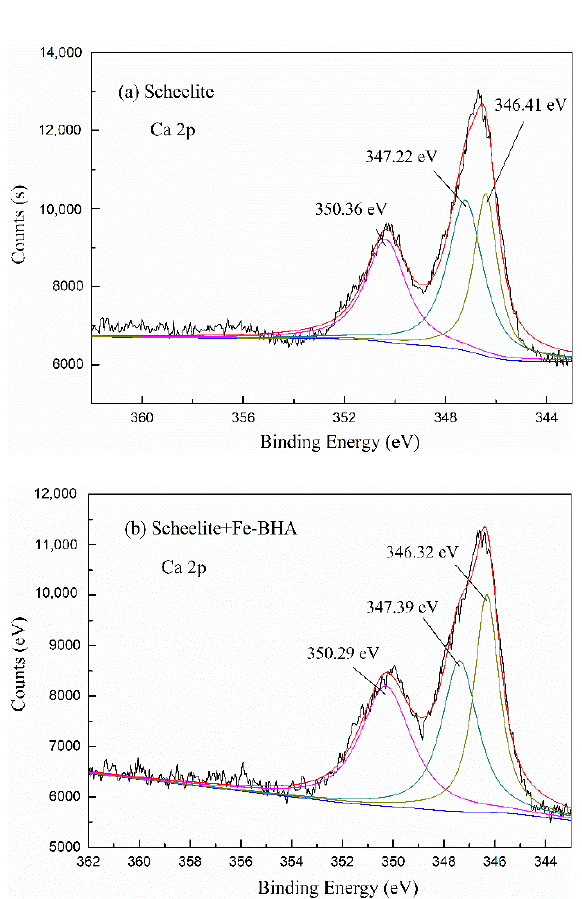
Figure 8. Ca 2p XPS spectra of scheelite ( a ) and scheelite conditioned with Fe-BHA ( b ).